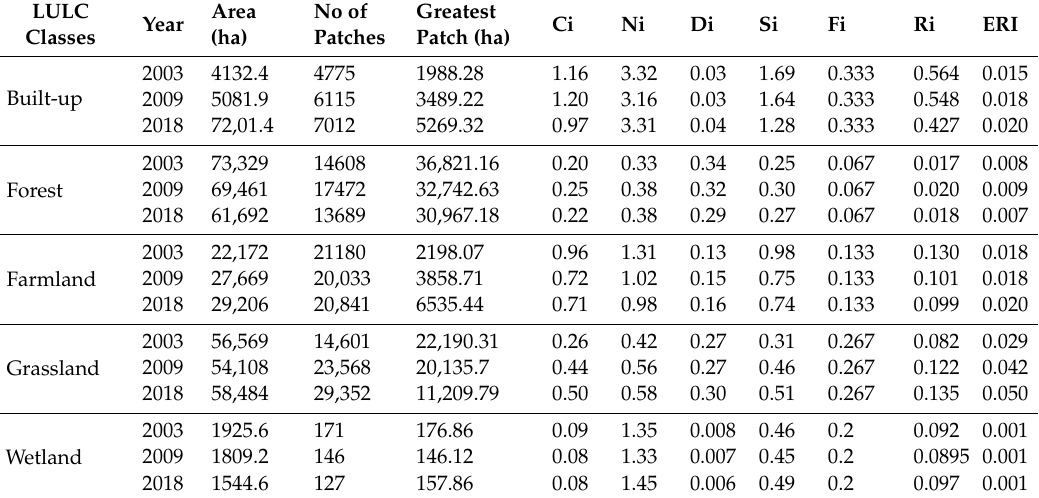
Table 10. Ecological risk indices for land cover classes of 2003–2018 (Ci: fragmentation index; Ni: isolation index); Di: dominance index; Si: disturbance degree index; Fi: ecological fragility index; Ri: loss index; ERI: ecological risk